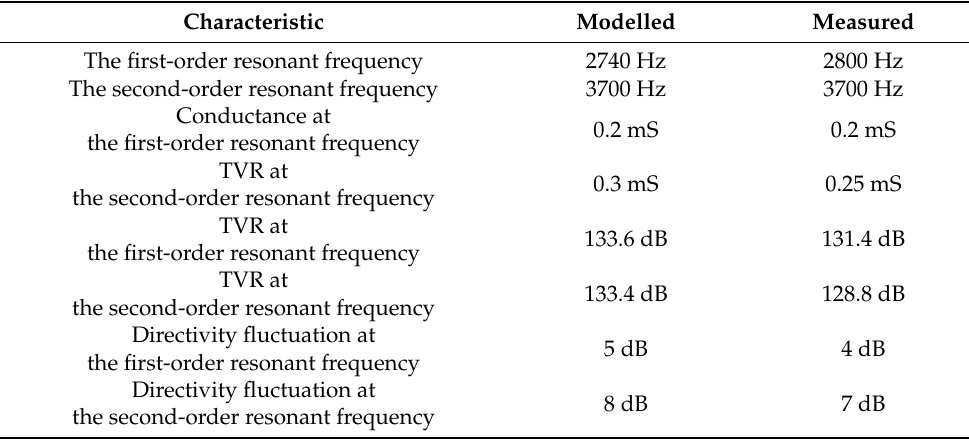
Table 2. Acoustic parameters of the